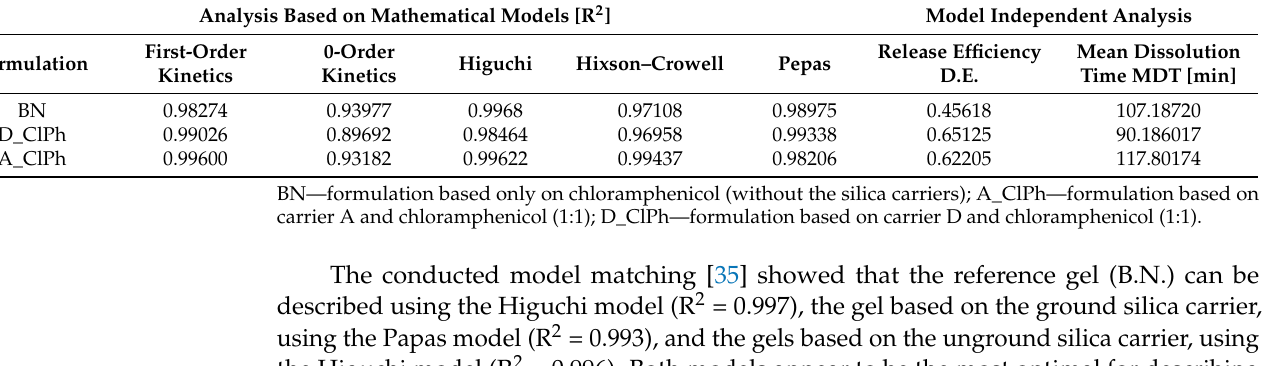
Table 6. In vitro release kinetic models of silica